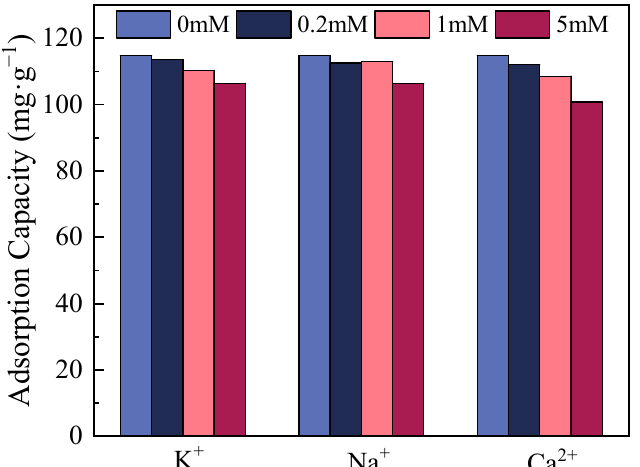
Figure 16. Effects of different concentration of coexisting cations on Pb 2+ absorption on to Ce-MCB.